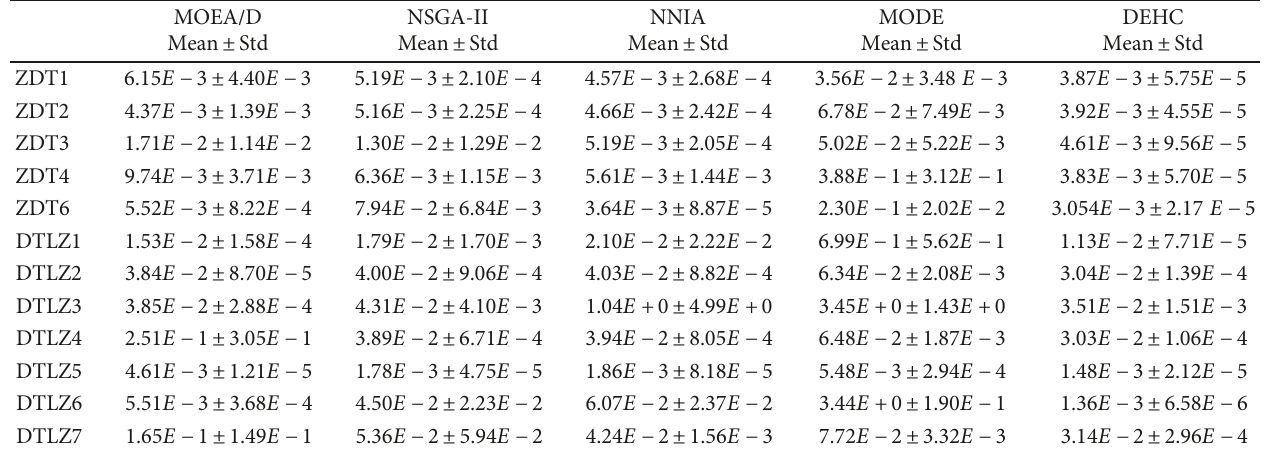
Table 1: The IGD comparison results of DEHC with 4 MOEAs on 12